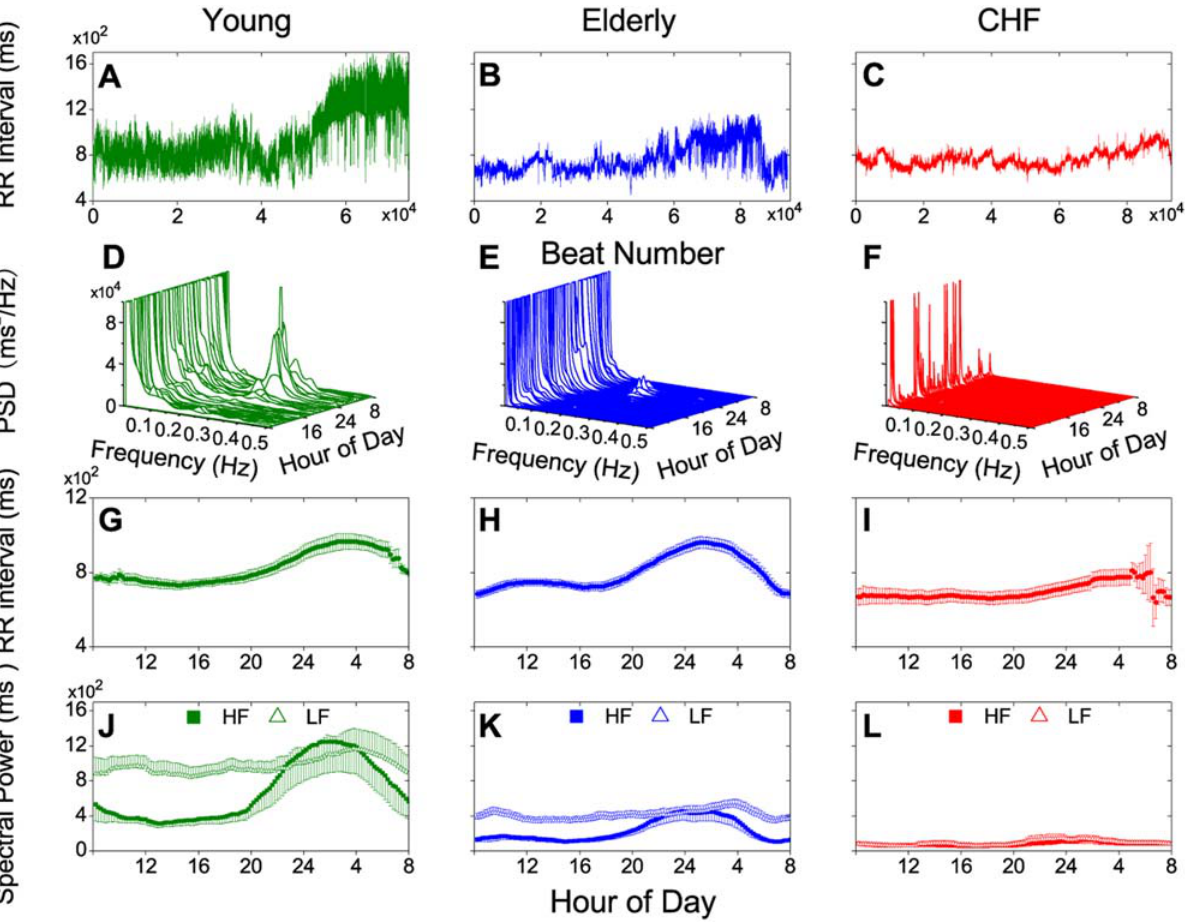
Figure 1. Circadian heart rate variability and mean beat-to-beat (RR) interval in young (green) or elderly subjects (blue) and patients with congestive heart failure (red) as revealed by Holter recordings (sampling rate was 128 Hz for the young group, 250 Hz for the CHF group and 1 kHz for the elderly group). A–C: 24-hr RR interval tachogram in one representative subject from each group. D–F: Corresponding spectral arrays with power spectral density vs. frequency in Hz evaluated by standard autoregression methods [2] at 30-min intervals. G–I: Mean RR intervals ( 6 SE) vs. time for each group. J–L: Corresponding HF (0.15–0.4 Hz) and LF (0.04–0.15 Hz) power. Data points for G–L were evaluated at 12-min intervals and averaged over a moving 3-hr time window for each subject before group